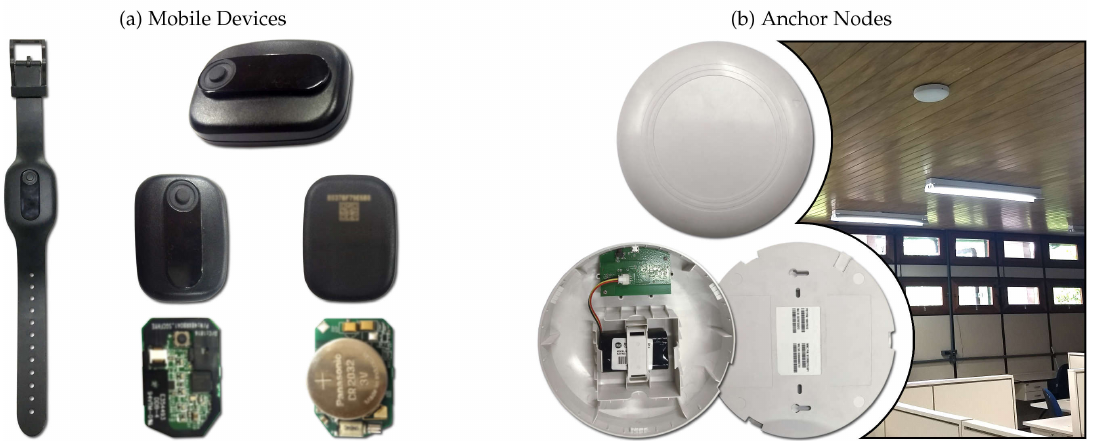
Figure 4. Testbed hardware: ( a ) mobile devices with Bluetooth communication; and ( b ) anchor nodes with Bluetooth and 900 Mhz communication (front, opened, back, and installed on the